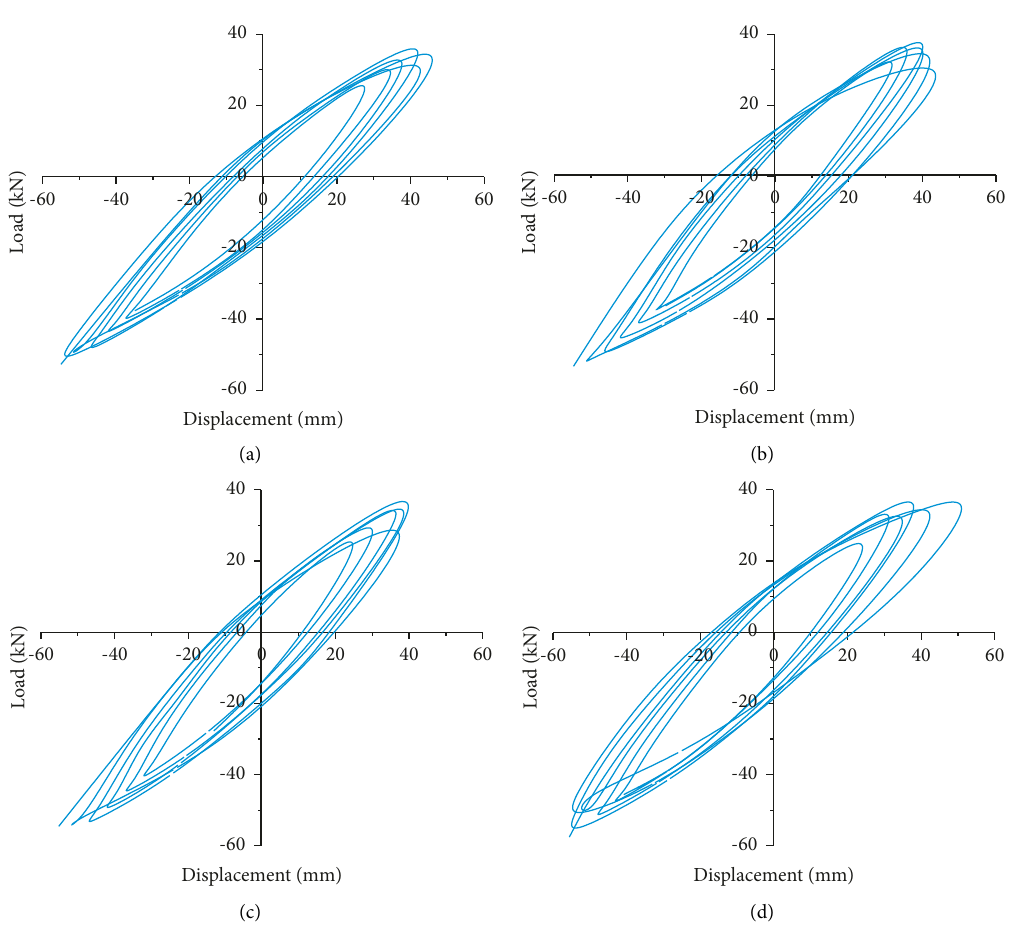
Figure 21: Hysteretic curves of joints with different sleeve heights. (a) 1h, (b) 1.2h, (c) 1.5h, and (d) 1.8